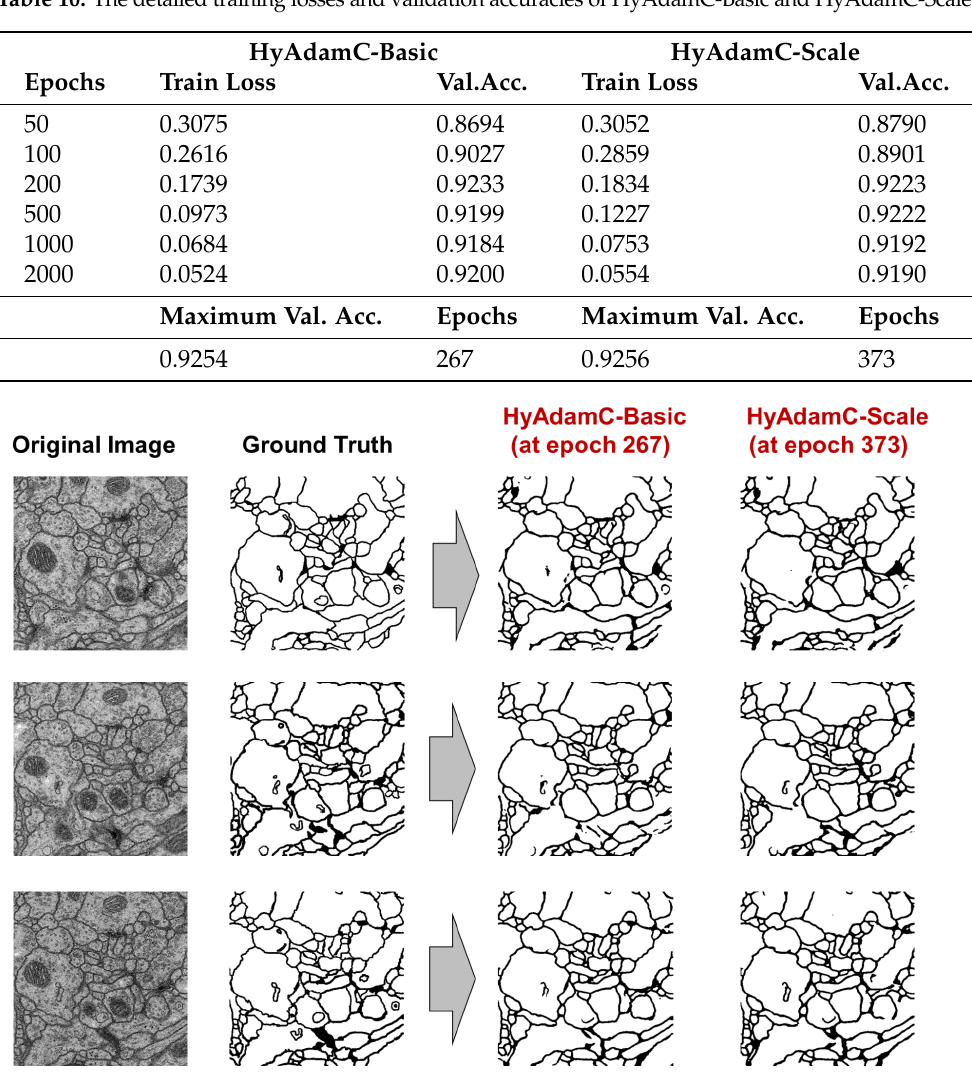
Figure 33. The images segmented by the U-Net trained by HyAdamC-Basic and HyAdamC-Scale. The left images show the original input images and their GT